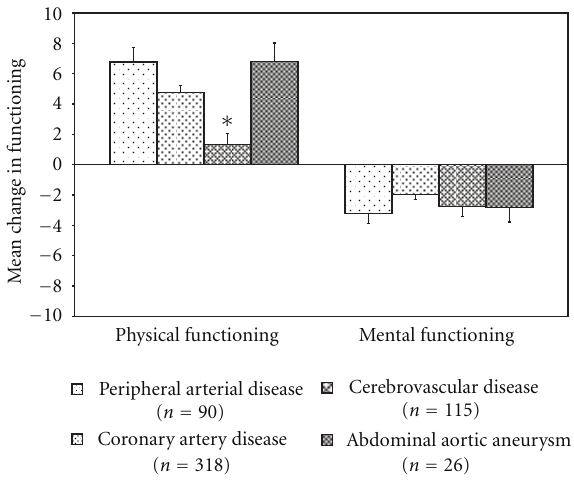
Figure 1: Mean changes in physical and mental functioning for di ff erent locations of symptomatic atherosclerotic disease, adjusted for age, sex, baseline functioning, and follow-up time. Significant di ff erences, compared to other locations of symptomatic atherosclerotic disease, are indicated with an asterix.